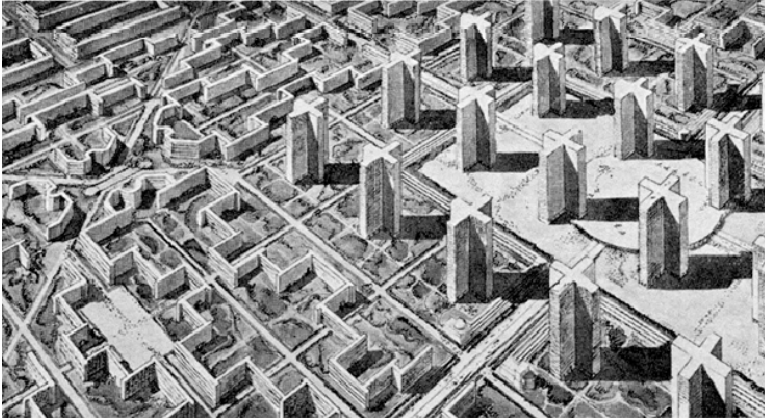
Figure 2. Ville Radieuse (The Radiant City) by Le Corbusier, homogenized tall buildings which ignore the place.